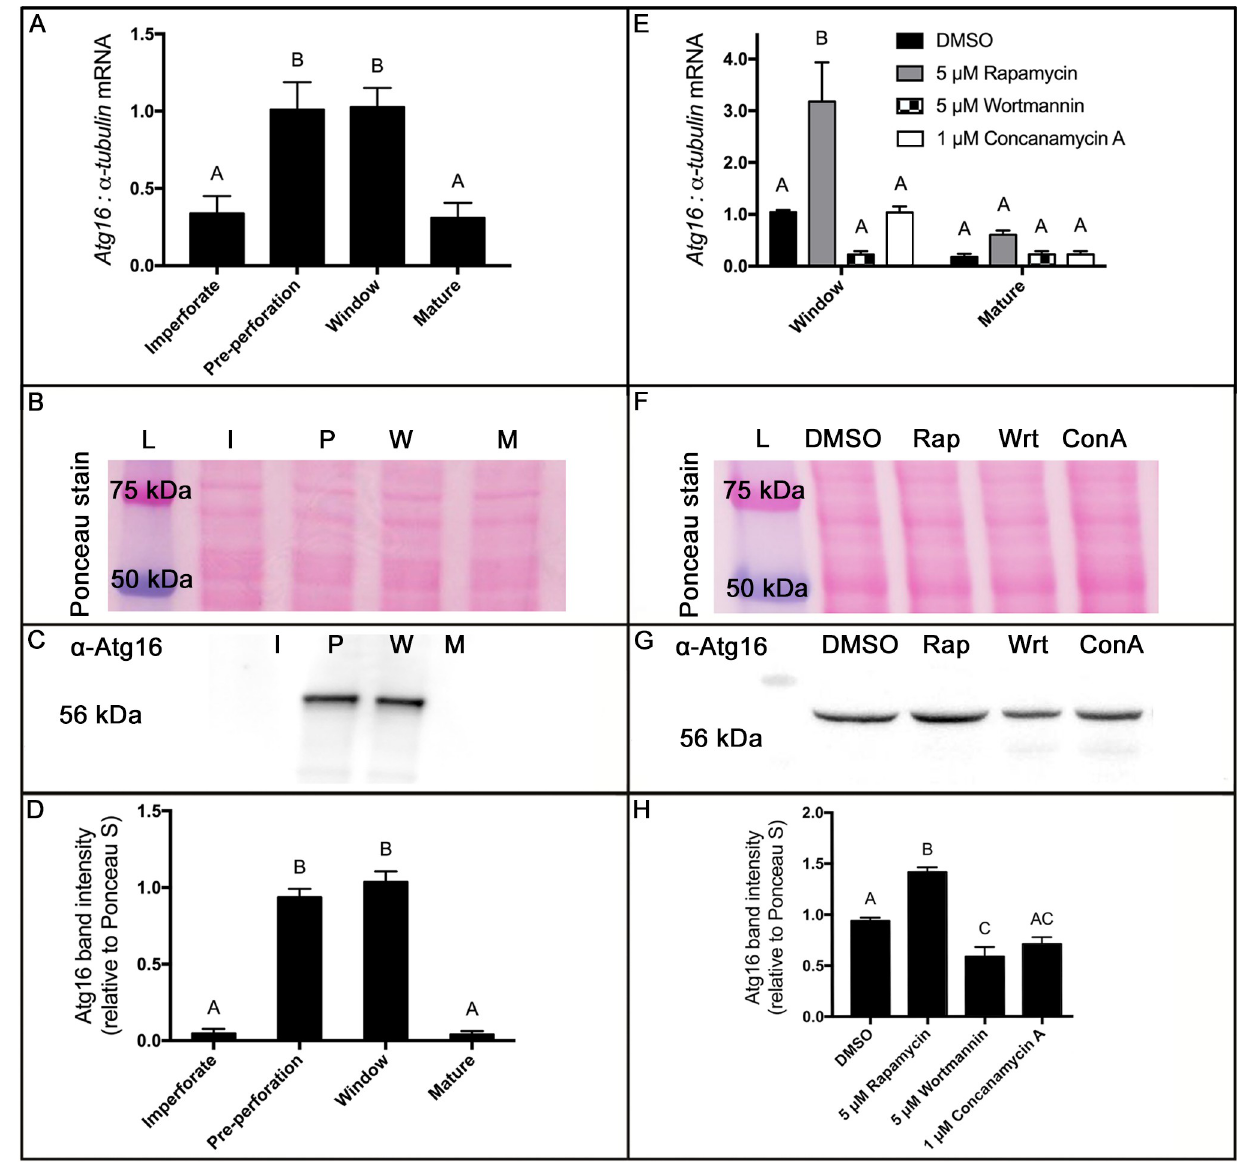
Fig 2. Detection of lace plant Atg16 in lace plant leaves. RNA and protein were extracted and probed for Atg16 from imperforate (I), pre-perforation (P), window (W), or mature (M) lace plant leaf stages ( A - D )or only window and mature leaves from plants treated with either 5 μ M rapamycin (Rap), 1 μ M wortmannin (Wrt), and 1 μ M concanamycin A (ConA) compared to DMSO control ( E - H ).( A and E ) The mean levels of Atg16 mRNA in different lace plant leaf stages were determined by qRT-PCR and normalized to lace plant α -tubulin levels. Protein extracts and a molecular protein standard (L) were resolved by SDS–polyacrylamide gels and blotted to nitrocellulose membranes. ( B and F ) Membranes and protein lanes were stained with Ponceau-S to serve as loading control before subsequent detection of the presence or absence of ~56 kDa sized Atg16 protein bands with anti-Atg16 antibody ( C and G ). ( D and H ) Immunoreactive protein bands were quantitated, and the ratio of Atg16 band intensity to the Ponceau lane signal was averaged. The experiments were performed in triplicate. Means not sharing any letter are significantly different. One-way ANOVA ( A , D and H ), or Two-way ANOVA, Tukey test ( E , P < 0.05; n = 3). Error bars represent the